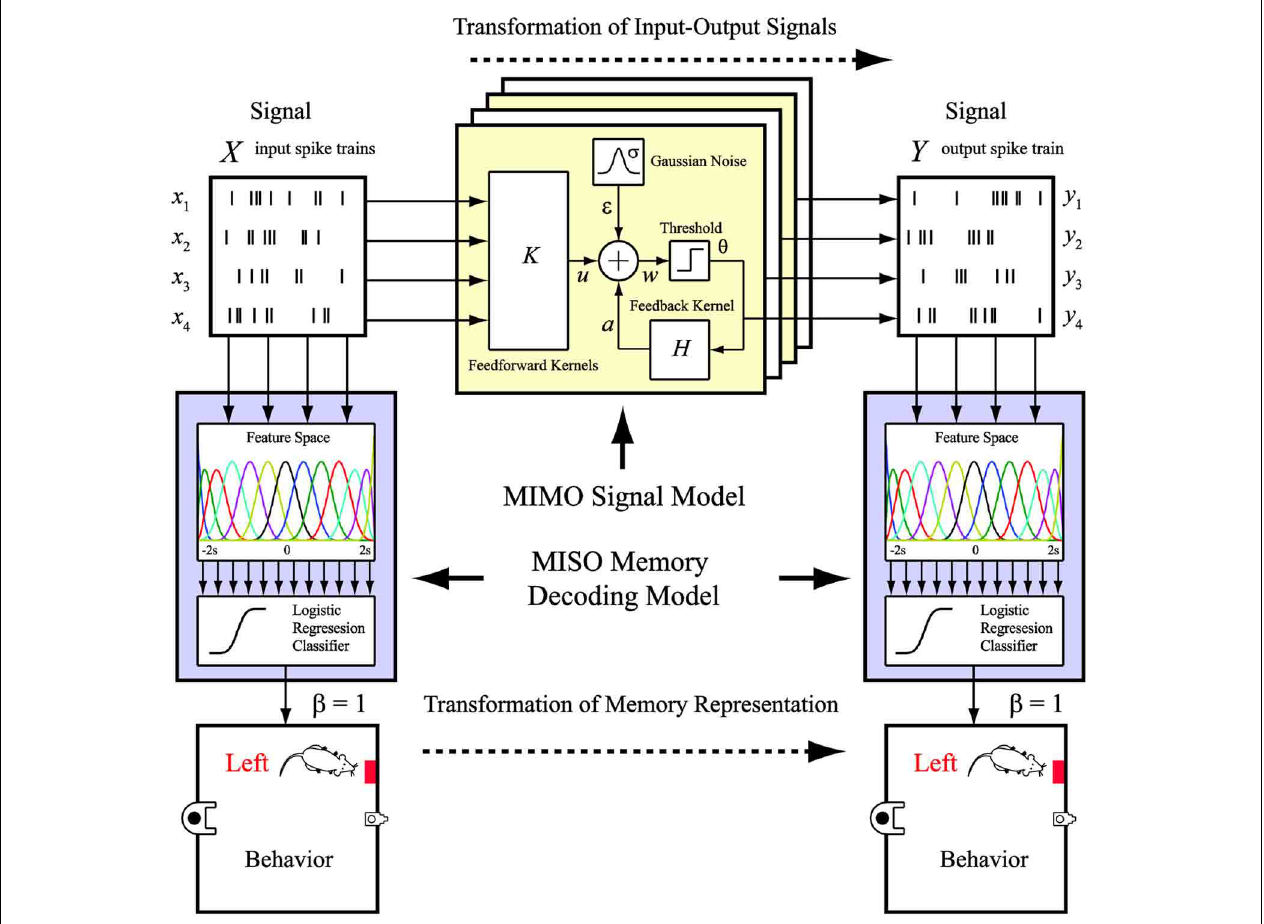
of spikes. The MISO memory decoding model predicts the memory (behavioral) events based on the input or output spatio-temporal patterns of